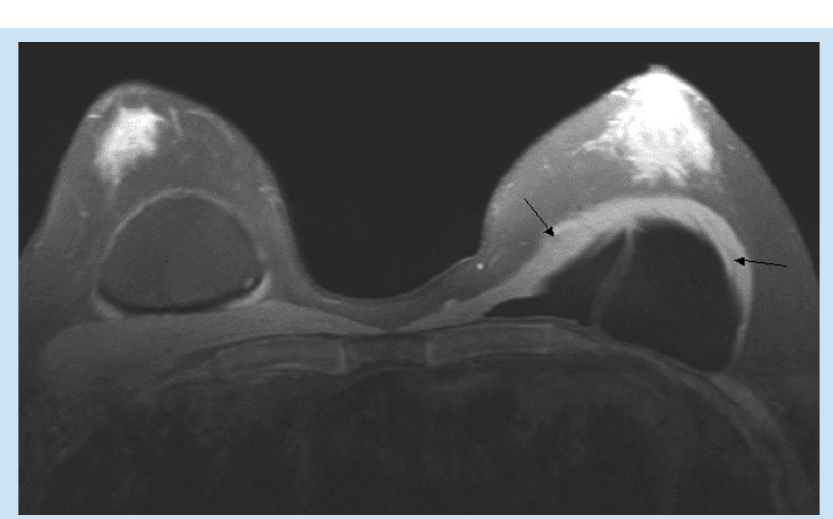
Fig.3.T2 inversion recovery magnitude or TIRM scan of a patient with a ruptured left breast prosthesis in the transverse plane. Note the prosthesis fluid collecting anterior to the breast capsule (arrows) with a rupture anteriorly of the elastomer